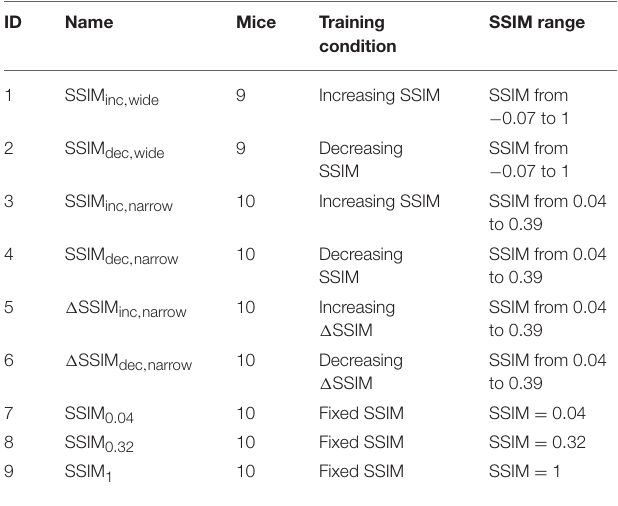
TABLE 1 | Groups of mice trained with varying or fixed stimulus similarity